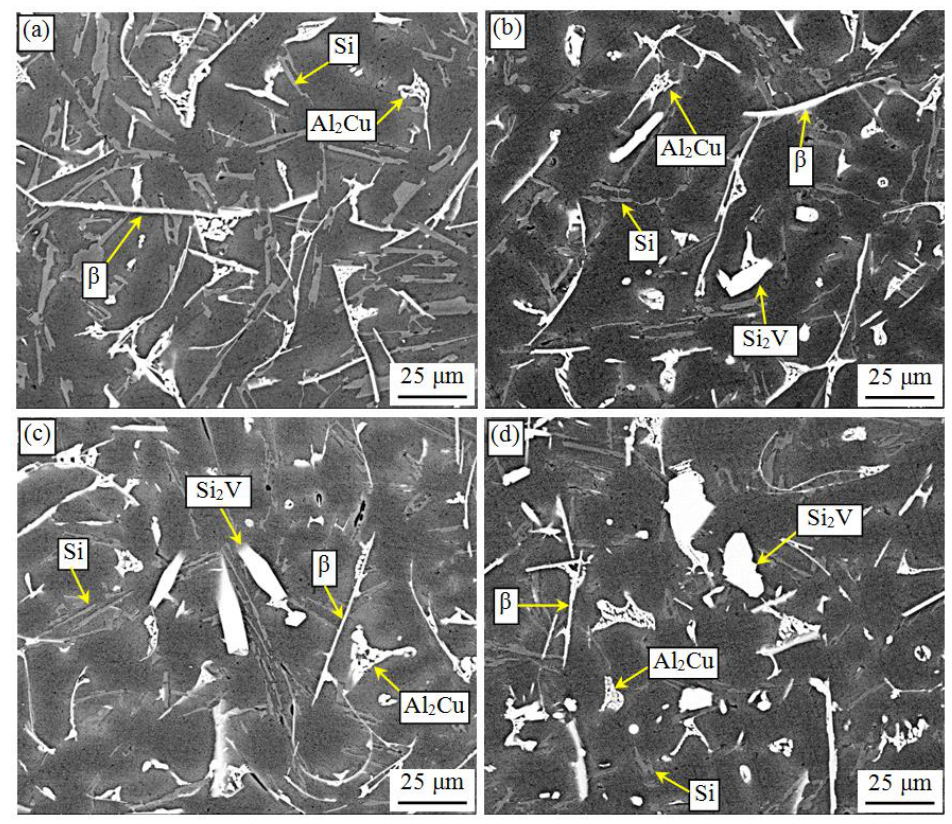
Figure 3. Scanning electron microscope (SEM) micrographs of as-cast gravity casting alloys with different vanadium contents (β stands for β-Al 5 FeSi): ( a ) A1 alloy; ( b ) A2 alloy; ( c ) A3 alloy; ( d ) A4 alloy.